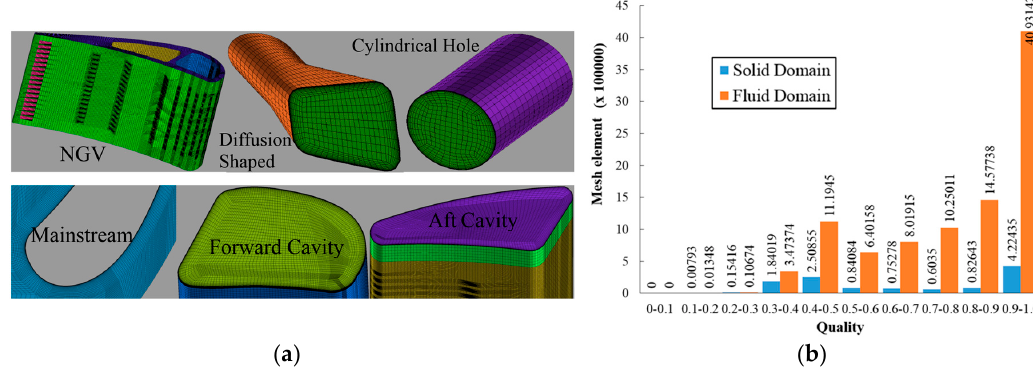
Figure 4. ( a ) Computational mesh; ( b ) quality distribution of computational mesh.